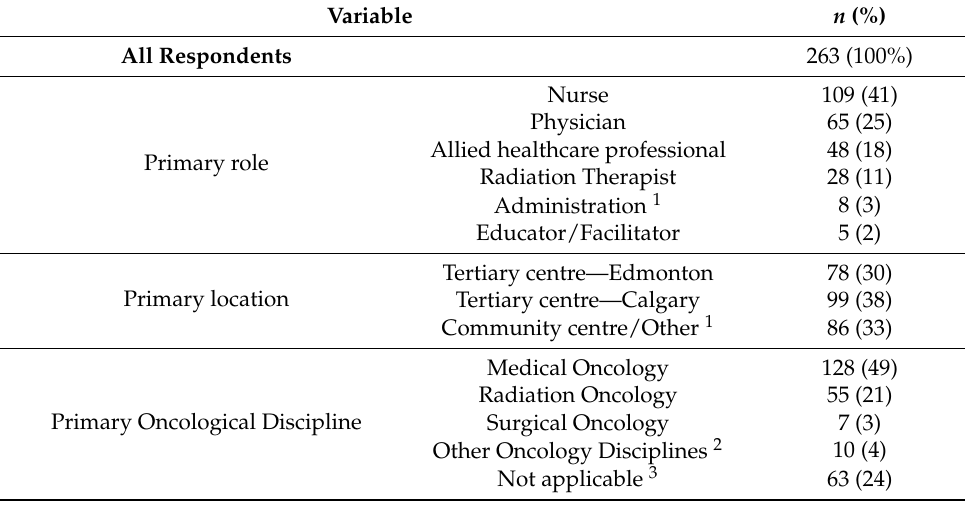
Table 1. Demographics of survey